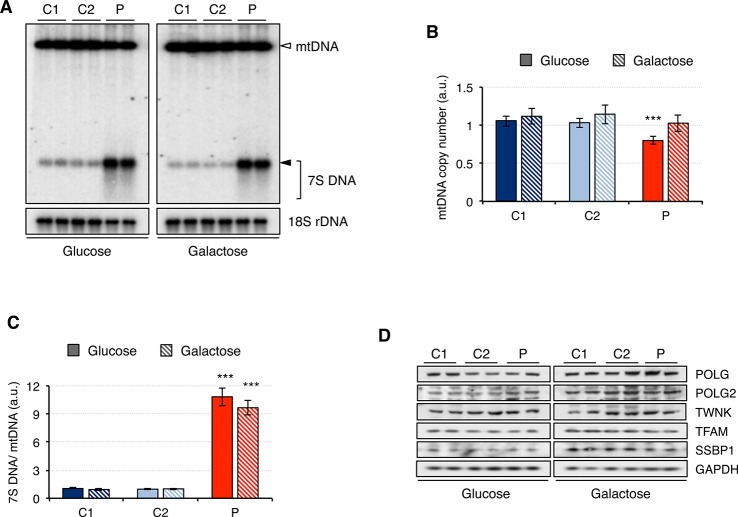
Mitochondrial DNA maintenance in mutant RNASEH1 fibroblasts. (A) Southern blot of total DNA digested with PvuII from control (C1 and C2) and patient (P) fibroblasts grown in either glucose- or galactose-containing medium. A radioactive probe against mtDNA was used to detect both linearized mtDNA (empty arrowhead) and 7S DNA (filled arrowhead and bracket), while a probe against 18S rDNA was used as loading control. (B) Relative mitochondrial DNA copy number in control (C1 and C2) and patient (P) fibroblasts grown in either glucose- or galactose-containing medium, calculated as the linearized mtDNA/18S rDNA signal ratio. Data are shown as mean ± SD, n = 4, ***p < 0.001. (C) 7S DNA levels in control (C1 and C2) and patient (P) fibroblasts grown in either glucose- or galactose-containing medium calculated as the 7S DNA/linearized mtDNA/18S rDNA signal ratio. Data are shown as mean ± SD, n = 4, Student’s unpaired two-tail t-test, ***p < 0.001. (D) Western blot analysis of mitochondrial proteins involved in mtDNA maintenance in control (C1 and C2) and patient (P) fibroblasts grown in either glucose- or galactose-containing medium. GAPDH was used as loading control.